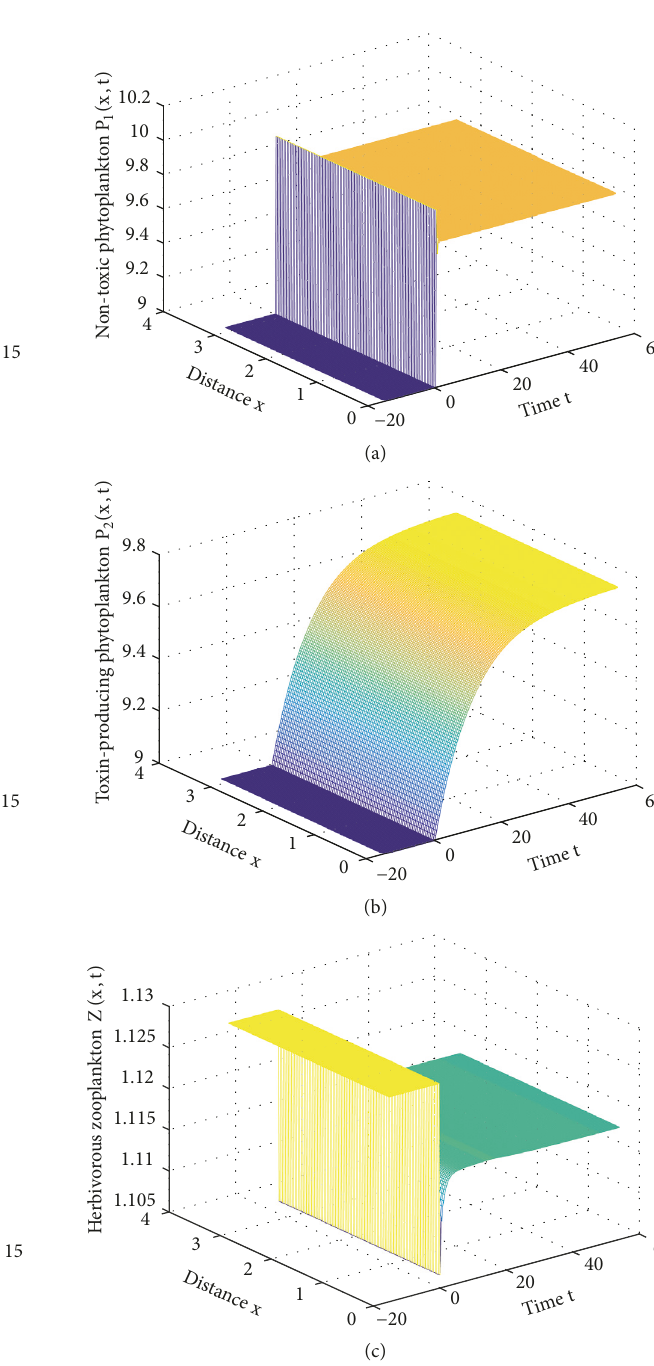
Figure 2: The equilibrium solution 𝐸 ∗ of (3) is asymptotically stable when 𝜏 = 0.65 < 𝜏 0 .